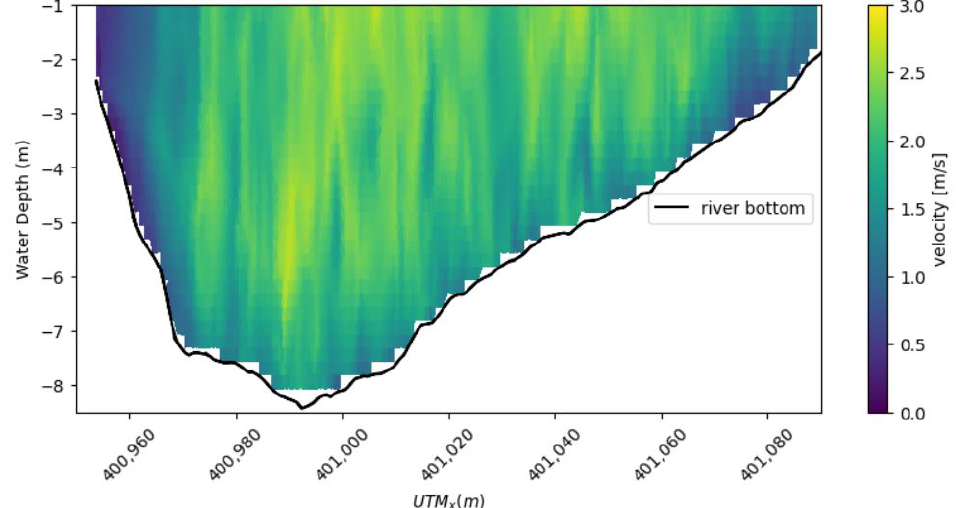
Figure 5. Velocity magnitude collected by an ADCP linearly interpolated onto an ideal linear transect. The ideal linear transect is shown in Figure